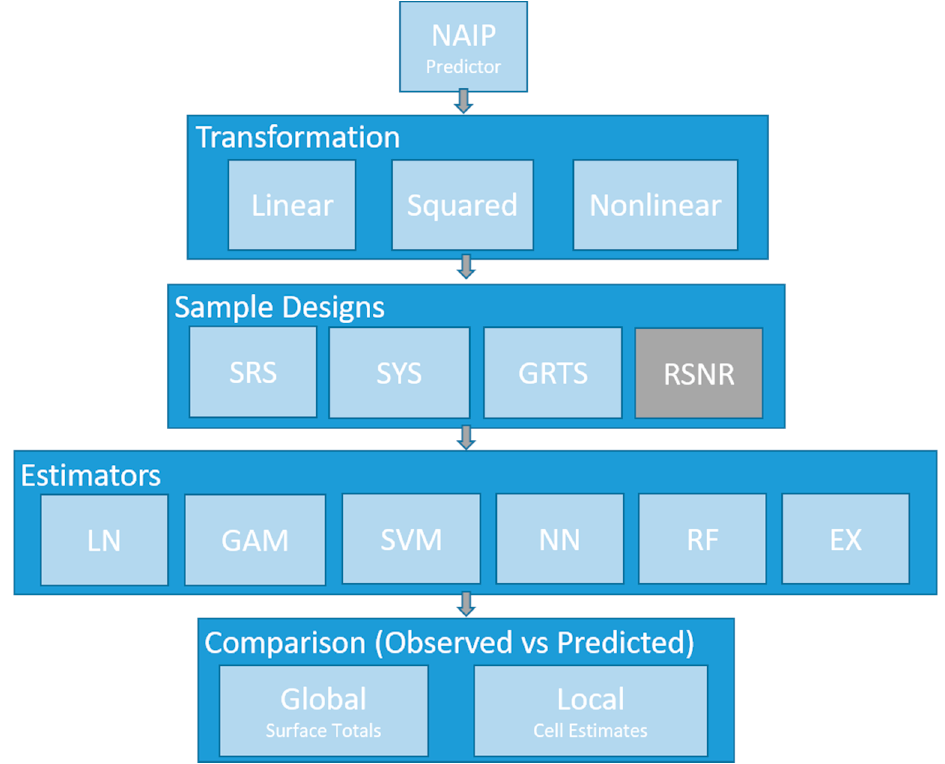
Figure 1. Diagram of simulations and workflow to determine the impact of sample designs on model and design-based estimates. The gray box in sample design denotes a probabilistic sample design for a subset of geographic space. NAIP = National Agriculture Imagery Program imagery; SRS = simple random sample, SYS = systematic random sample, GRTS = generalized random tessellation stratified, RSNR = simple random sample near roads, LN = linear model; GAM = generalized additive models, SVM = support vector machines, NN = neural networks, RF = random forests, EX = Horvitz Thompson expansion estimator.